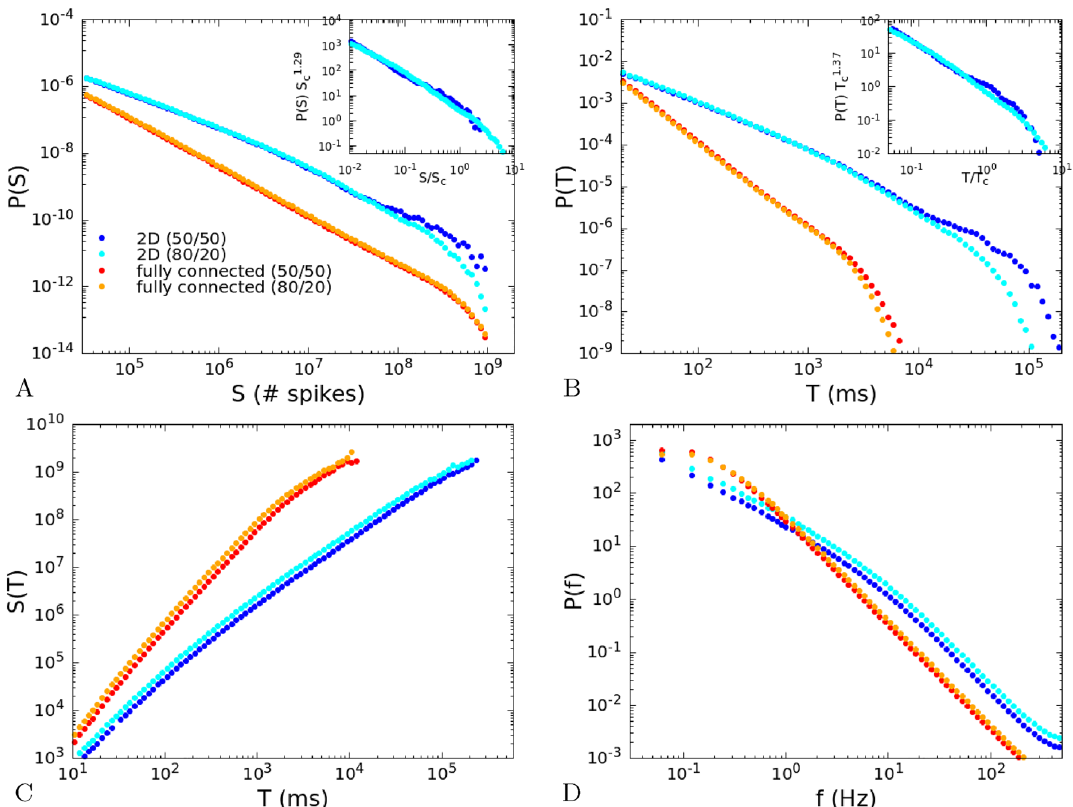
Figure 7. ( A ) Avalanche size distribution P ( S ) for the fully-connected and 2D models, and two different fractions of excitatory and inhibitory neurons, 50/50 and 80/20. The total number of neurons on each site is 2 10 8 in all cases. Other parameters as in Figs. 4 and 5 . Inset: collapse of the distributions in the 2D case. × 10 8 in the 50/50 case and 10 8 in the 80/20 case. ( B ) Avalanche duration distribution. Inset: The cut-off S c is 4 × 10 4 in the 50/50 case and 10 4 in the 80/20 case. collapse of the distributions in the 2D case. The cut-off T c is 3 × ( C ) Mean size of the avalanche as a function of the duration. ( D ) Power spectrum of the firing